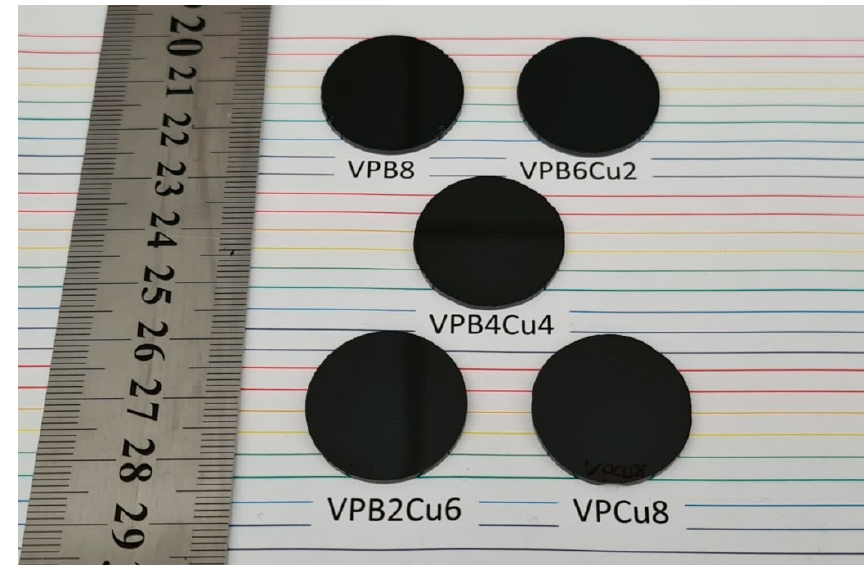
Figure 1. Physical appearances of Cu-doped VPB x Cu y glasses along with their codes.